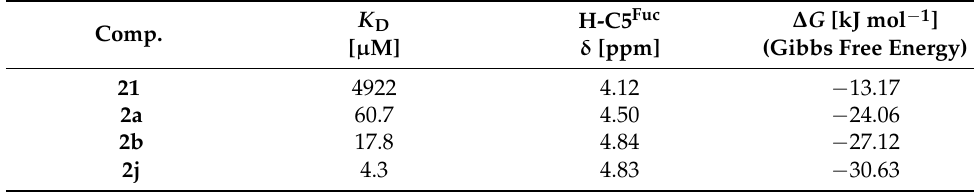
Table 3. K D and the calculated Gibbs free energies ∆ G = -RT ln K D .